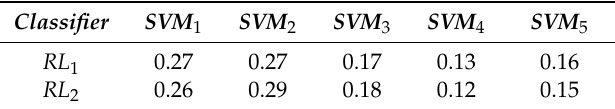
Table 3. Voting weights of the classifiers in each recognition layer for the recognition of adults, dogs and warm wind in the indoor environment.